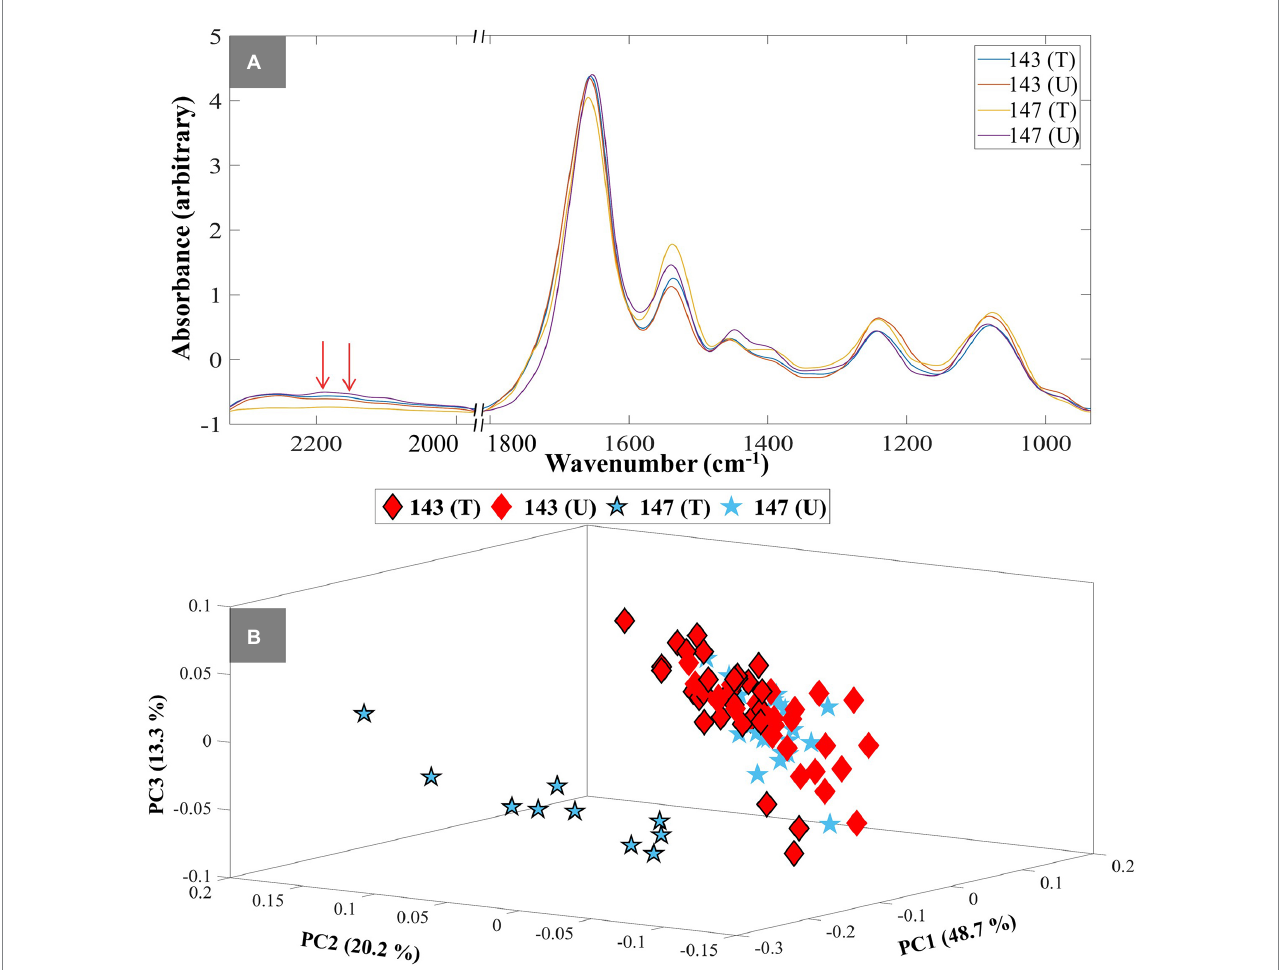
FIGURE 3 Single-cell O-PTIR spectral data of UPEC isolates at 3h timepoint (A) . Red arrows show the C–D stretching vibrational peaks at 2,159 cm − 1 and 2,195 cm − 1 . Different colored lines and numbers represent the different isolates and are also indicated in the figure. The letters (T) and (U) indicate TMP-treated and untreated conditions. 3D PCA scores plot of O-PTIR spectral data at 3 h timepoint (B) . The blue colored stars represent susceptible isolates and the red colored diamonds represent resistant isolates. The black outline represents TMP-treated groups, while those without it represent untreated groups. Different symbols and numbers represent the different UPEC isolates in this study, the letters (T) and (U) indicate TMP-treated and untreated conditions. The percent total explained variance (TEV) is shown on the PC